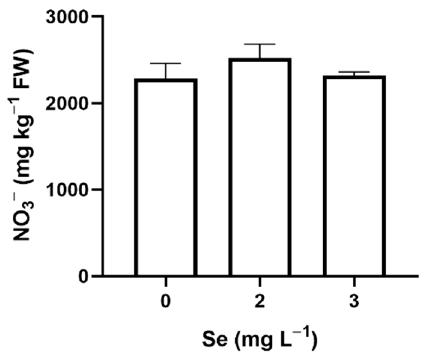
Figure 10. Nitrates (NO 3 − ) content, measured at maturity in leaves of basil plants treated with different concentrations of Se at pre-transplanting. Means ( n = 3) flanked by different letter are statistically different for p = 0.05 after Tukey ’ s test.